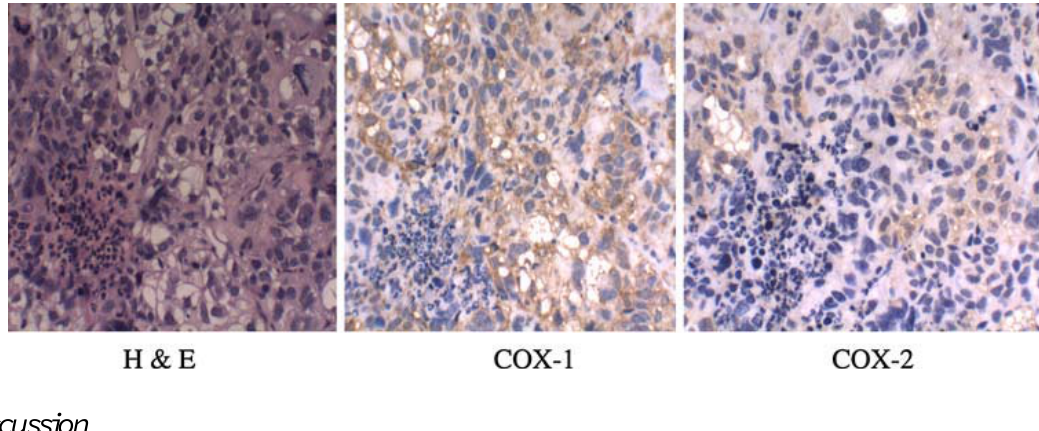
Figure 5. Immunohistochemical analysis of COX-1 and COX-2 expression in untreated tumor